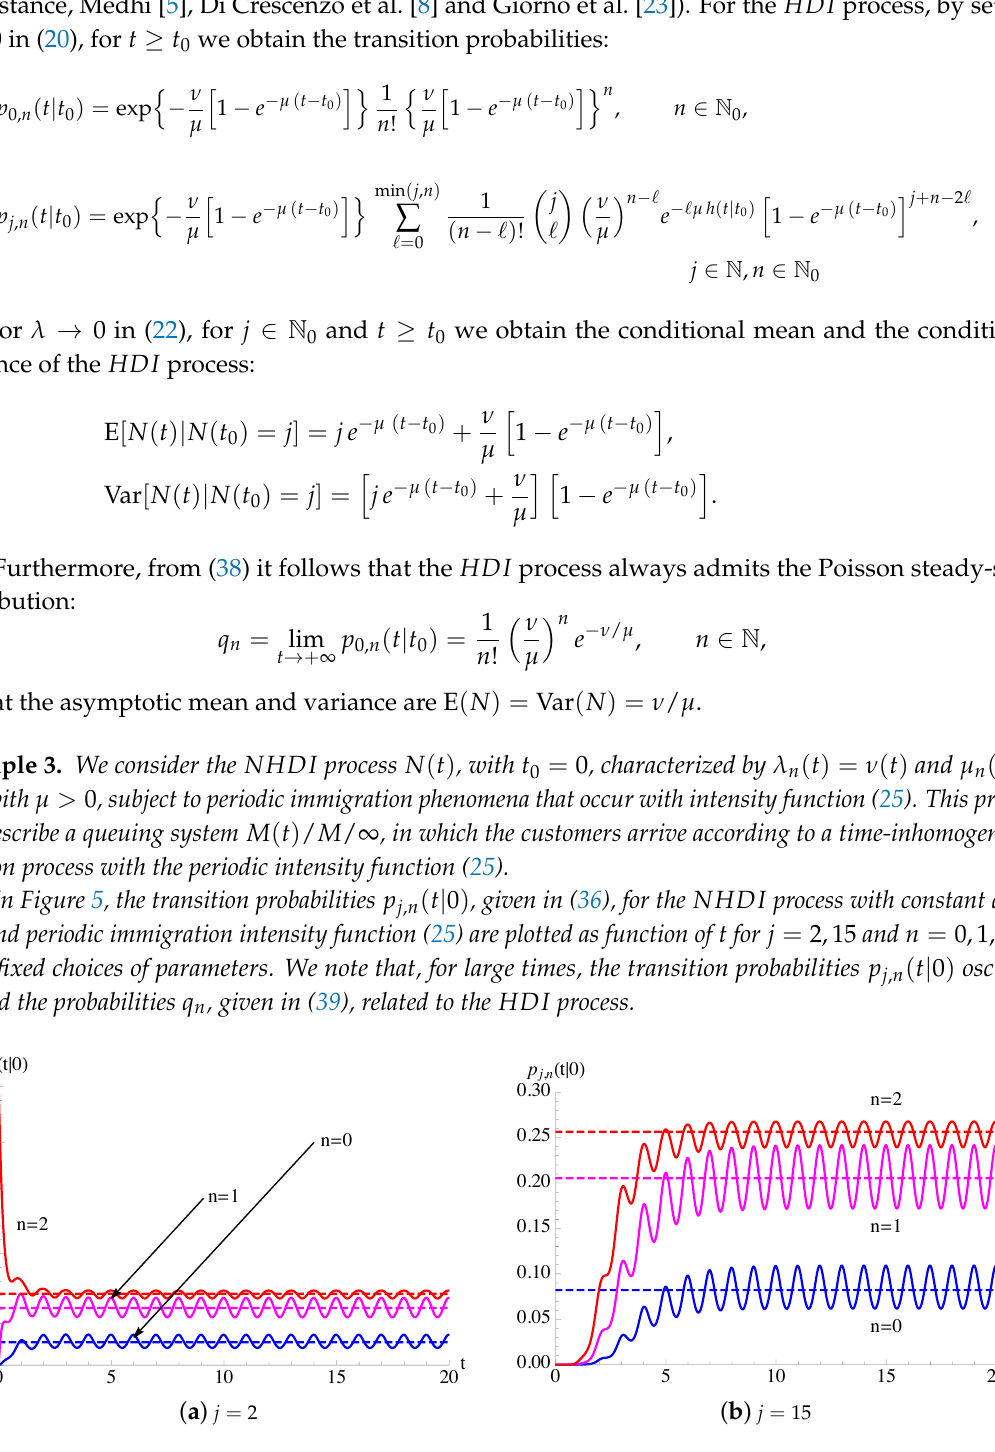
Figure 5. For the NHDI process, having λ n ( t ) = ν ( t ) and µ n ( t ) = µ n , with ν ( t ) given in (25), the probabilities p j , n ( t | 0 ) are plotted as function of t for µ = 0.8, ν = 2.0, a = 0.9, Q = 1.0 with n = 0,1,2. The dashed lines indicate the probabilities q 0 , q 1 , q 2 , given in